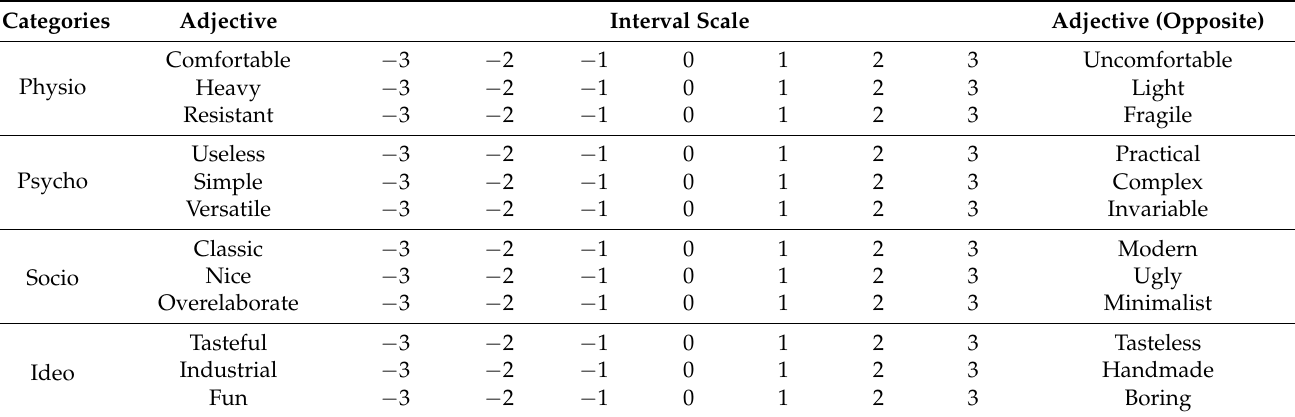
Table 1. Bipolar pairs used to evaluate the chair on a 7-interval